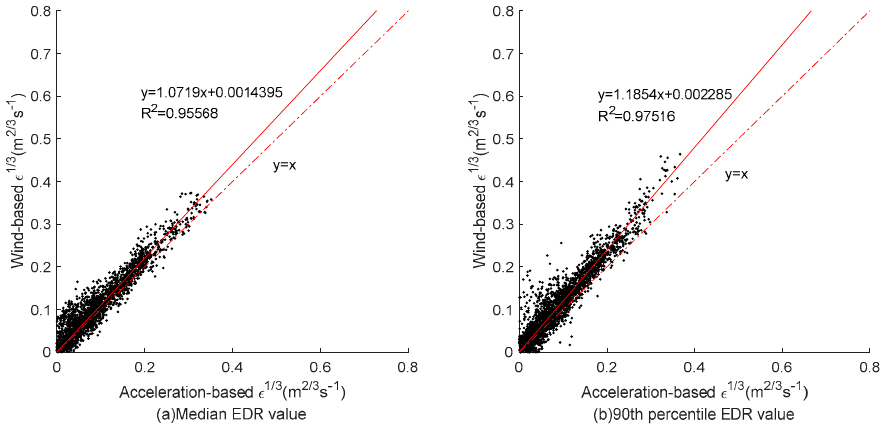
Figure 12. Comparison of EDR estimation. ( a ) median EDR value; ( b ) 90th percentile EDR value.